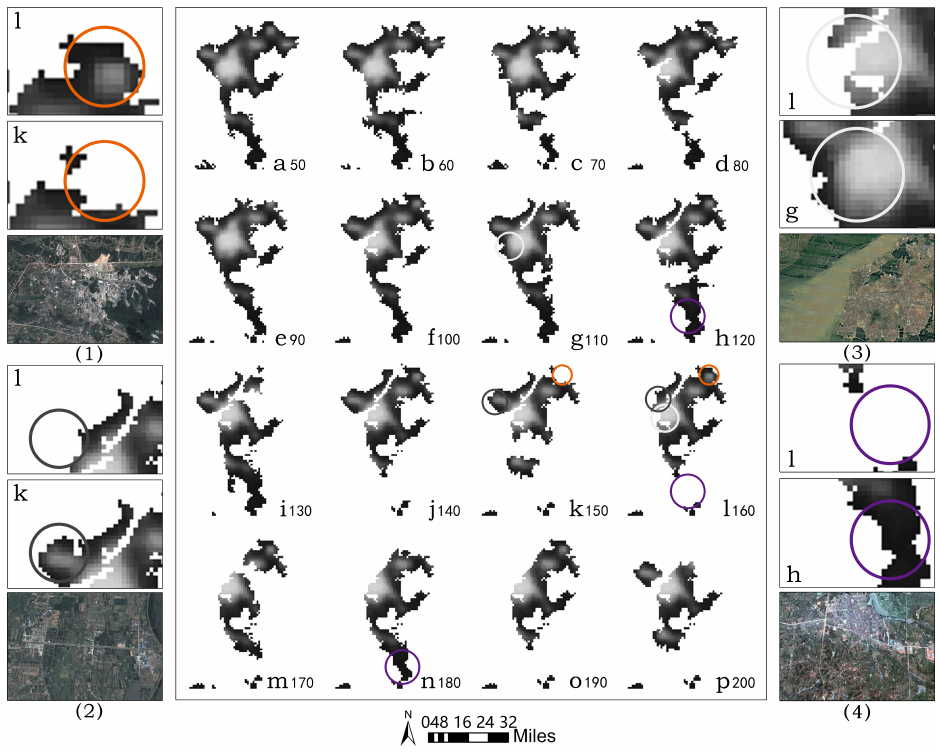
Figure 5. 2012 comparison of superpixel block size parameter